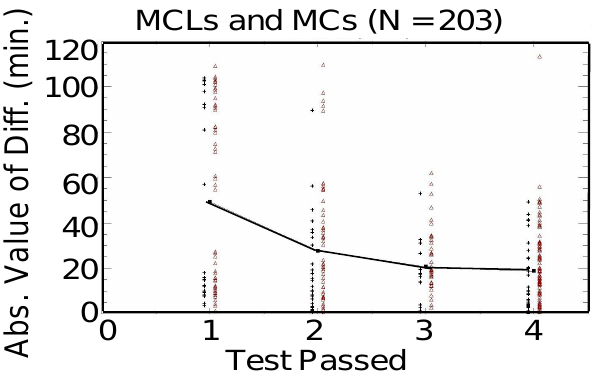
Fig. 11. The absolute value of either 1t 1 =[ t B *– t B (VI)] (for the MCs) or 1t 0 =[ t B *– t B (auto)] (for the MCLs) is plotted against the 1 number of tests passed for the combined results of all 81 MCs (black crosses) and 122 MCLs (red triangles). In each column, i.e., for each fixed number of tests passed, we indicate by a small black box where the average value is located, and we connect the boxes with line segments to emphasize the trend, which clearly shows smaller differences for greater number of tests